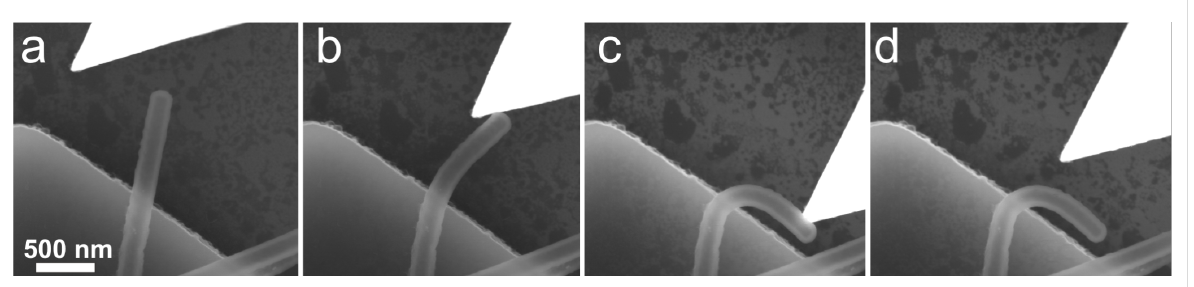
Figure 2: HRSEM images of in situ bending of silica NT. Intact NT (a), slightly bend NT (b), significantly bend NT (c), NT after tip removal (d). Radius of curvature 225 nm.